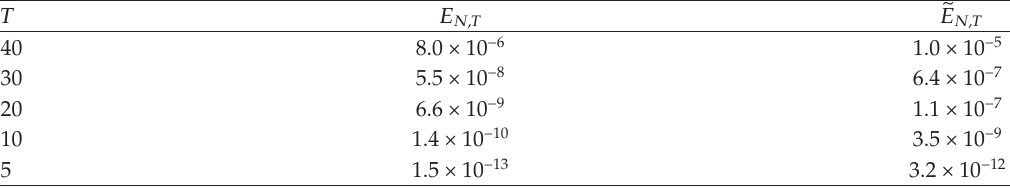
(cid:25) E N,T for α (cid:5) 5 and N (cid:5)